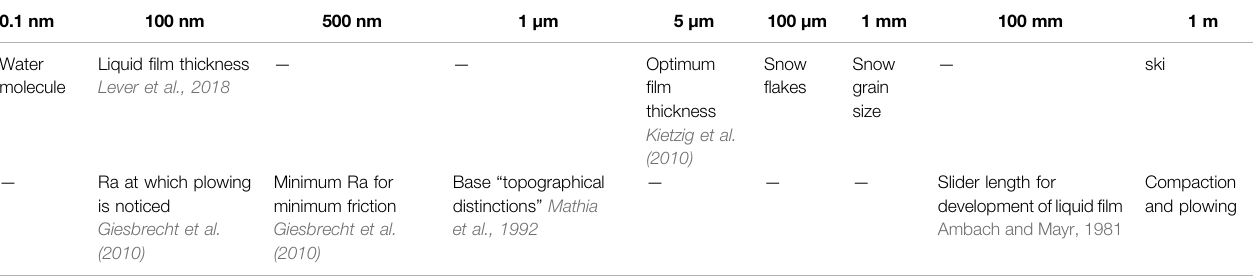
TABLE 1 | Orders of magnitude of scales for topographically related phenomena for snow and ice friction. Sources are supposed general knowledge or as cited. 0.1